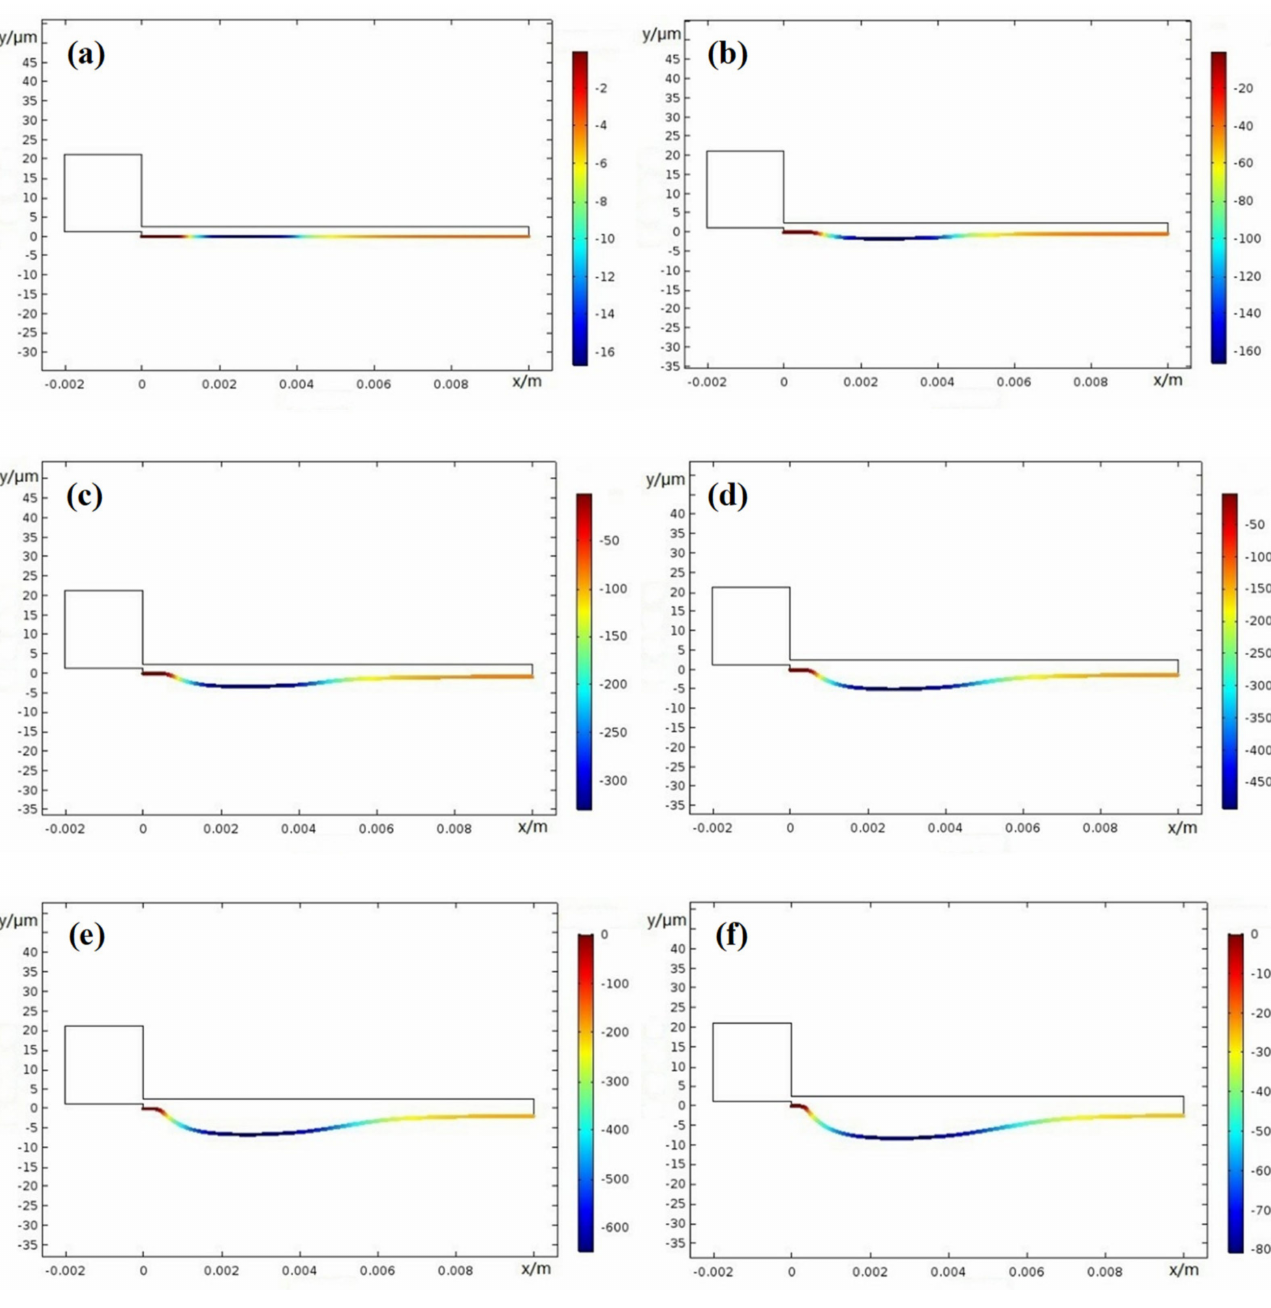
Figure 18. Damage evolution of X100 crevice corrosion at width W = 0.25 mm: ( a ) 0 weeks; ( b ) 10 weeks; ( c ) 20 weeks; ( d ) 30 weeks; ( e ) 40 weeks; ( f ) 50